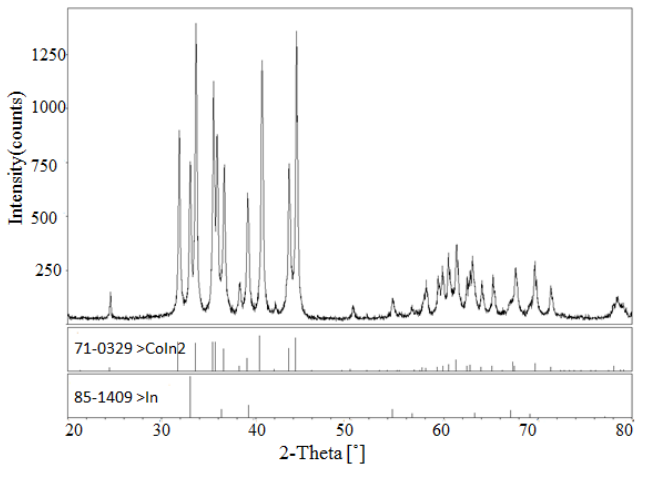
Figure 5. XRD pattern of No.33 (Co26Ni6In68).